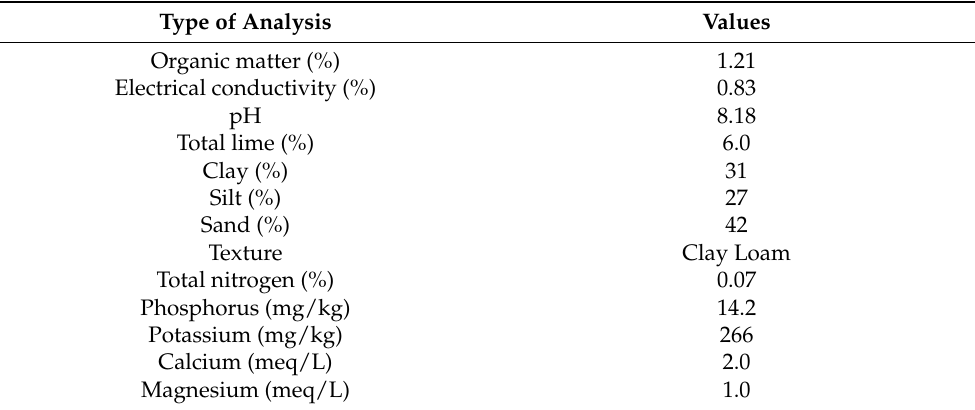
Table 2. Physicochemical properties of the farm soil. Type of Analysis Values Organic matter (%) 1.21 Electrical conductivity (%) 0.83 pH 8.18 Total lime (%) 6.0 Clay (%) 31 Silt (%) 27 Sand (%) 42 Texture Clay Loam Total nitrogen (%) 0.07 Phosphorus (mg/kg) 14.2 Potassium (mg/kg) 266 Calcium (meq/L) 2.0 Magnesium